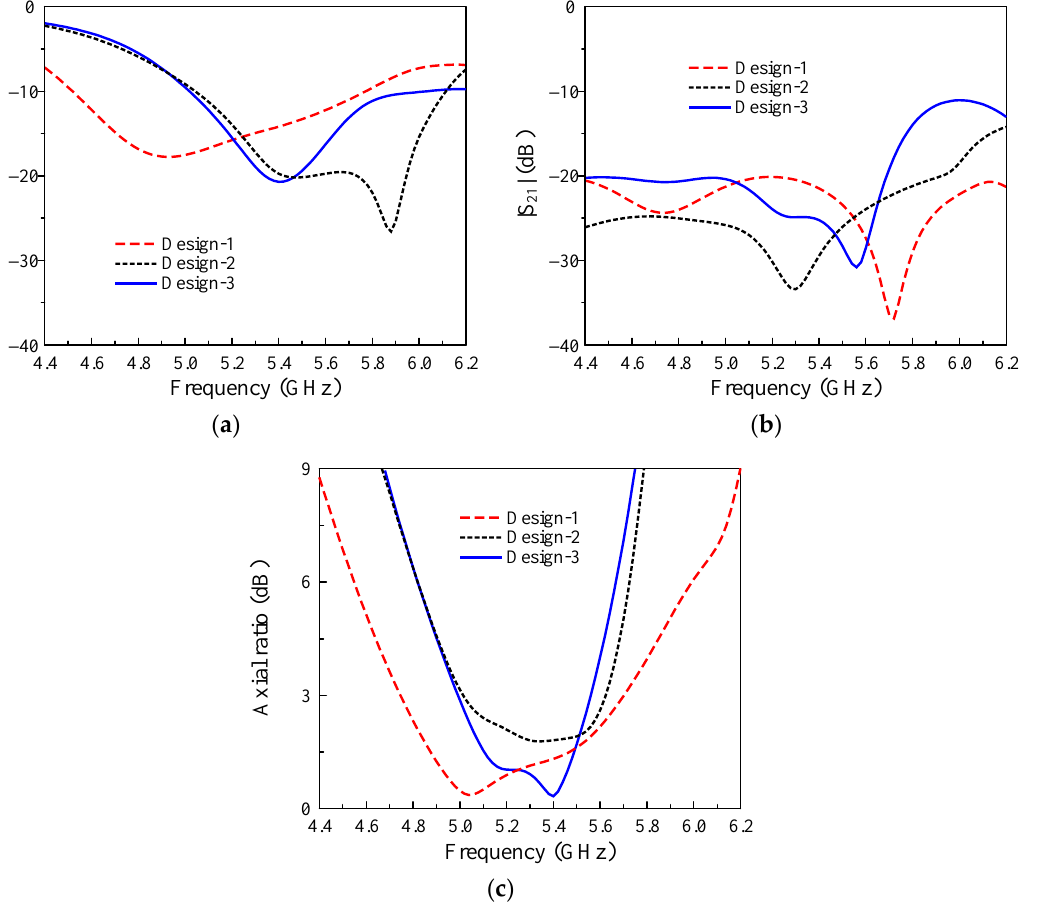
Figure 5. Simulated performance of different MIMO antennas. ( a ) Reflection coefficient (|S 11 |), ( b ) transmission coefficient (|S 21 |), and ( c ) axial ratio (AR).